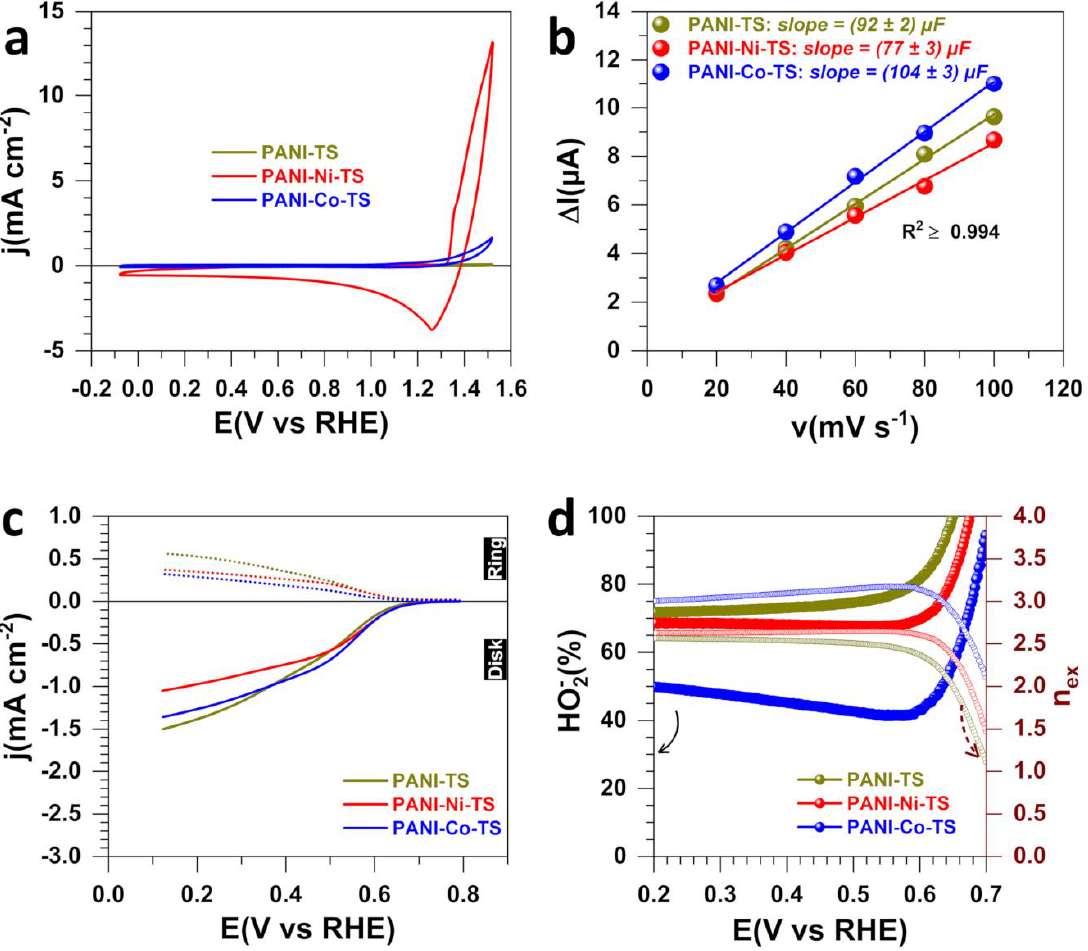
Figure 2. Electrochemical characterization for the materials obtained after polymerization (5 °C, 13 h) and stabilization (air, 350 °C, 2 h). ( a ) iR-drop uncorrected CV (N 2 -saturated 1 M KOH, 25 °C, 100 mV s −1 , 0 rpm). ( b ) Capacitive current ( Δ I a = I a − I c ) vs. scan rate at E(V RHE ) = 0.8 (PANI-TS), 1.2 (PANI-Ni-TS) and 0.7 (PANI-Co-TS). ( c ) iR-drop uncorrected LSV of ORR at RRDE (O 2 -saturated 1 M KOH, 25 °C, 5 mV s −1 , 1600 rpm, E ring = 1.2 V RHE ). ( d ) HO 2 − % (left) and number of transferred electrons per molecule of O 2 (right y -axis) from panel ( c ).